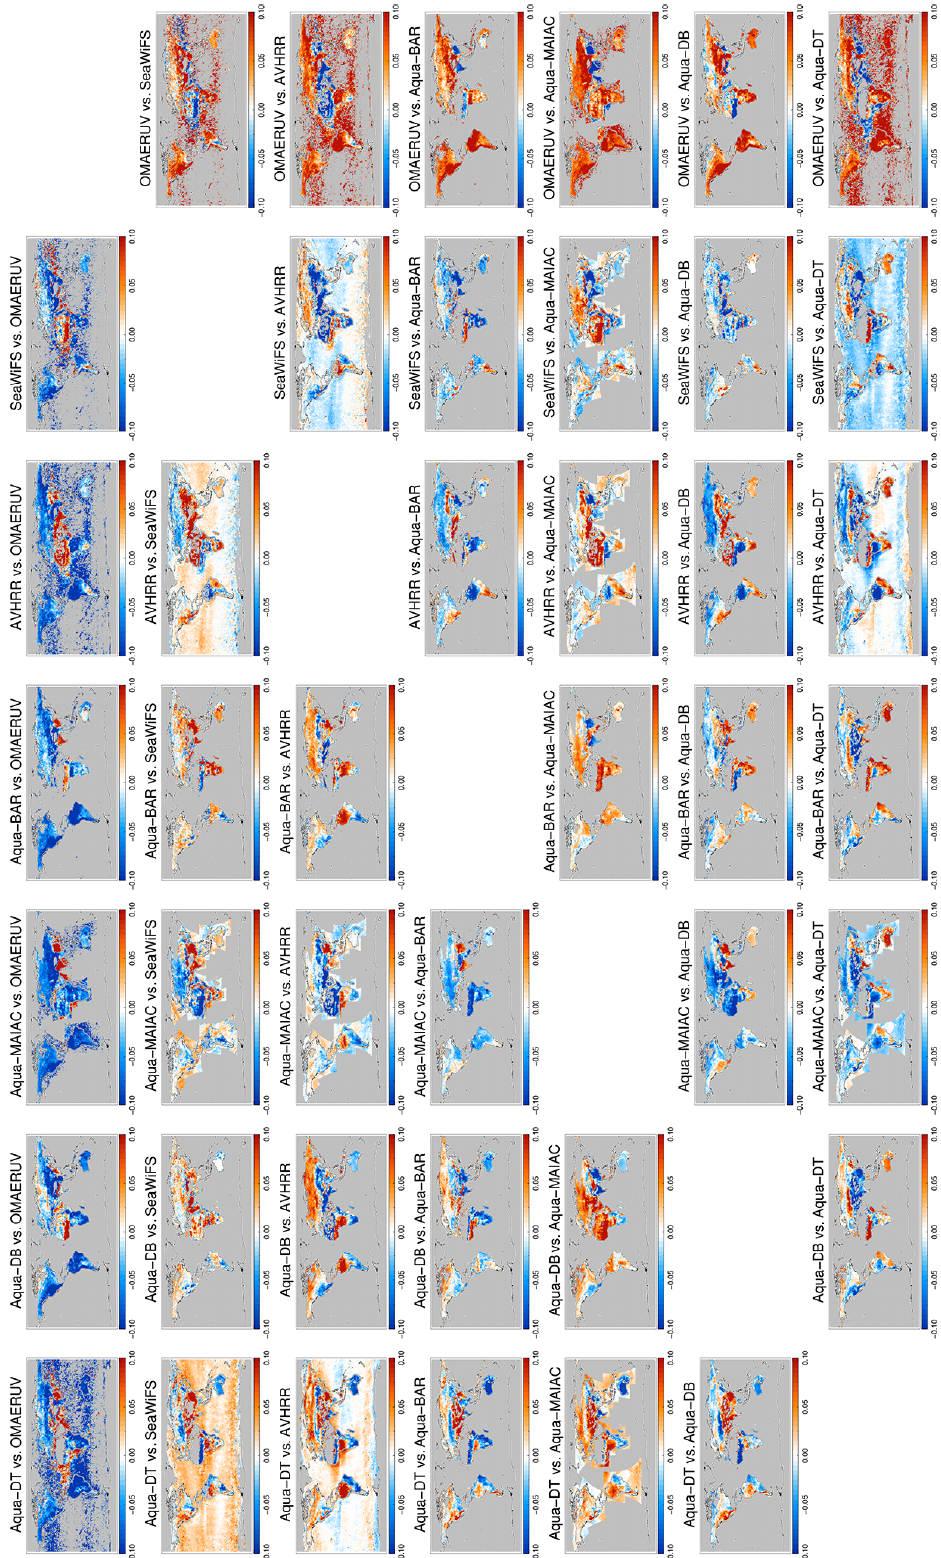
Figure 14. Global maps of the 3-year averaged difference in AOD for satellite products on afternoon satellites. Products were collocated pair-wise within